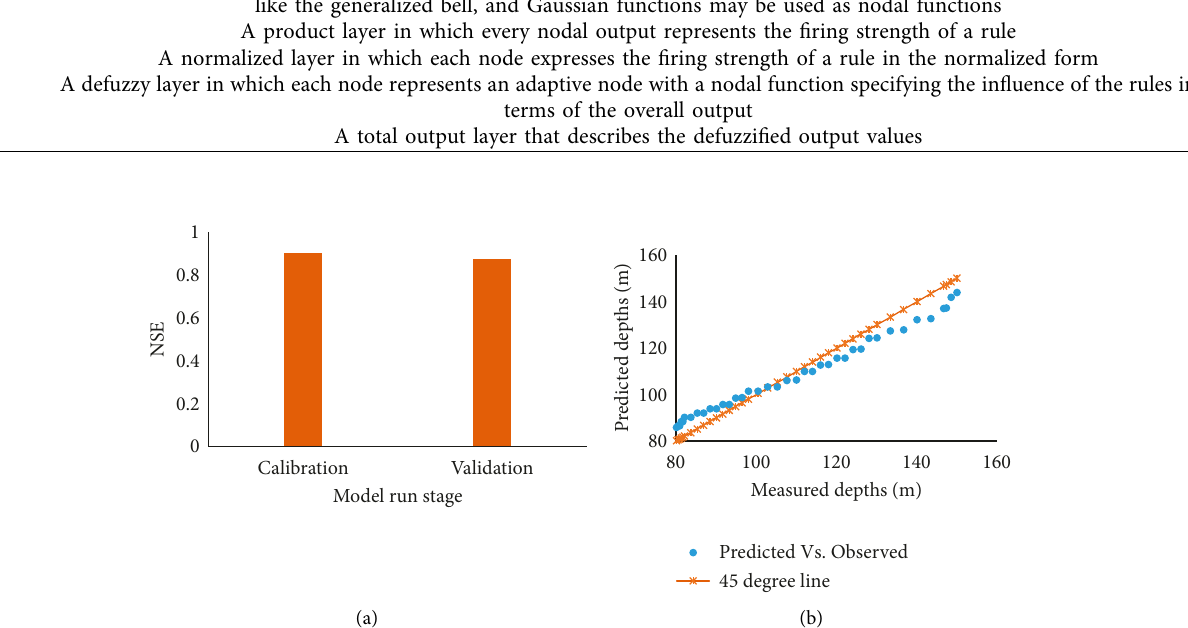
Figure 6: MODFLOW results. (a) The values of NSE. (b) Comparison of simulated versus observed groundwater depths and 1:1 line (45 o